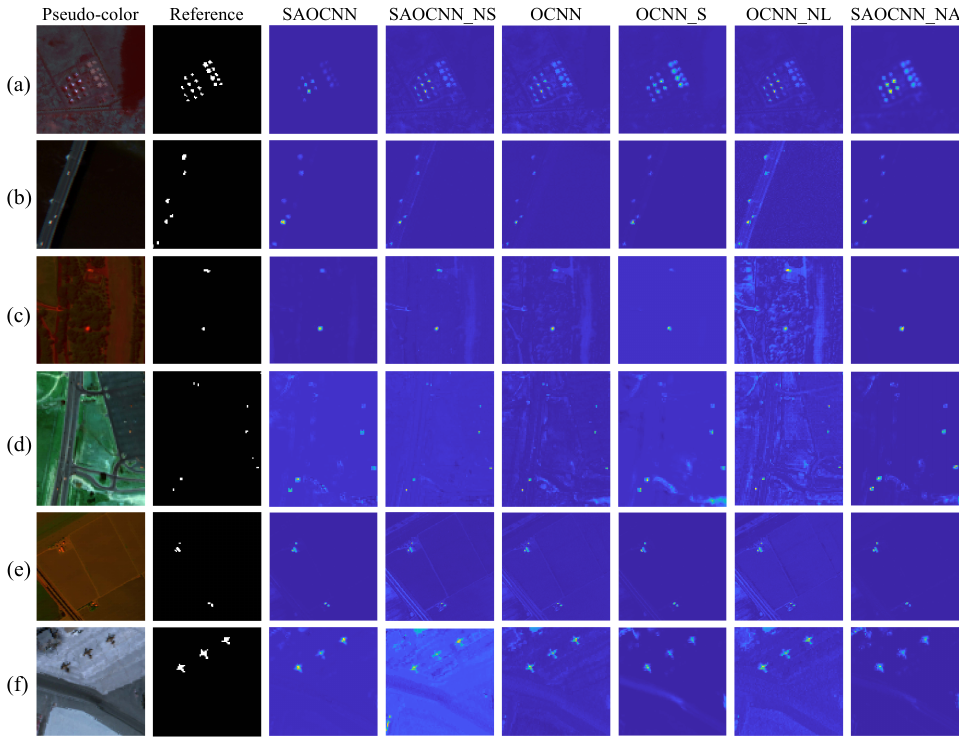
Figure 10. Anomaly detection maps of ablation study. ( a ) Coast. ( b ) Pavia. ( c ) DC Mall. ( d ) HYDICE.